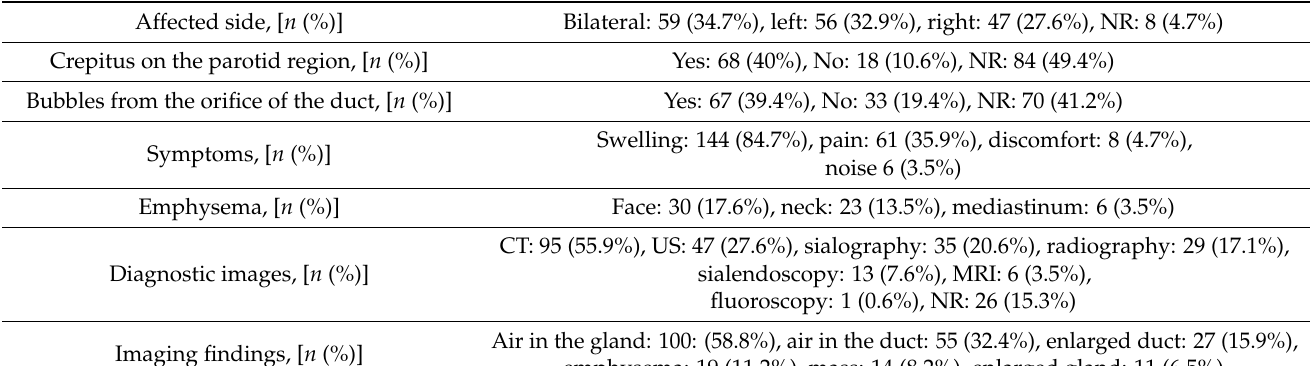
Table 1. Symptoms and diagnostic images. NR; not reported, CT; computed tomography, US; ultrasound, MRI; magnetic resonance imaging.